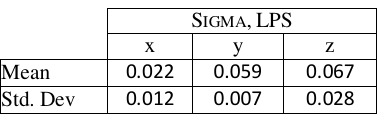
Figure 12. Leaves of tree of heaven ( Ailanthus altissima Table 13. Statistics of accuracies of TPs ground coordinates [m] S IGMA , LPS